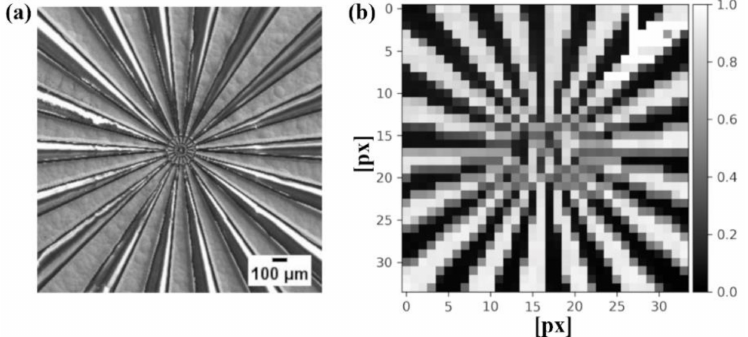
Figure 4. ( a ) Scanning electron microscope image of the test pattern (gold Siemens star) used for the 34 keV sub-pixel resolution hard X-ray imaging. ( b ) Low resolution image acquired by the Medipix Merlin 3.0 photon-counting detector. The number of pixels is 34 × 34 (pixel size: 55 µ m × 55 µ m) and equals the size of the 2D multi-lens array. The axes correspond to the pixel